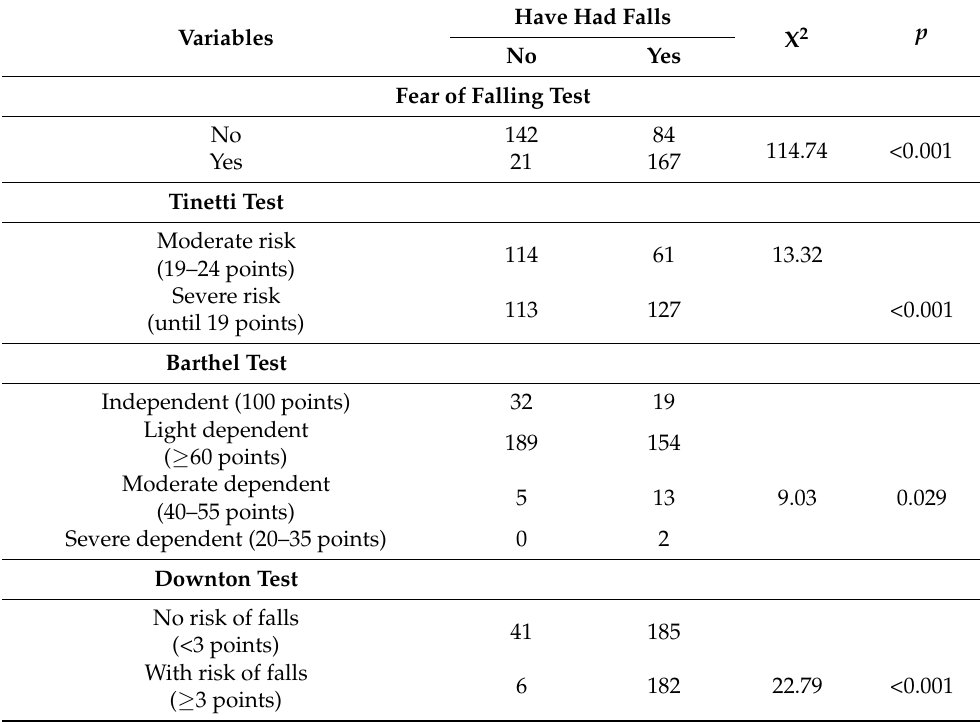
Have Had Falls X